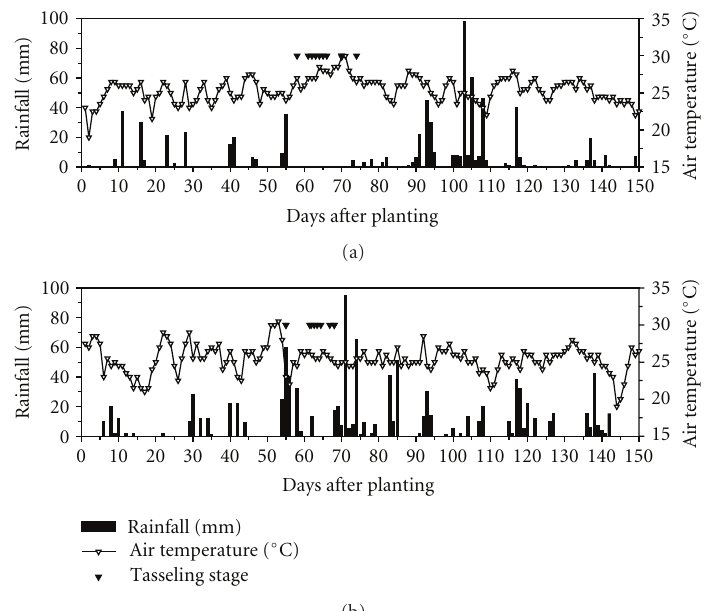
Figure 1: Daily rainfall and average air temperature after planting in 2005 and harvesting in 2006 (a) and planting in 2006 and harvesting in 2007 (b). Dark arrows indicate tasseling stage dates for the ten corn